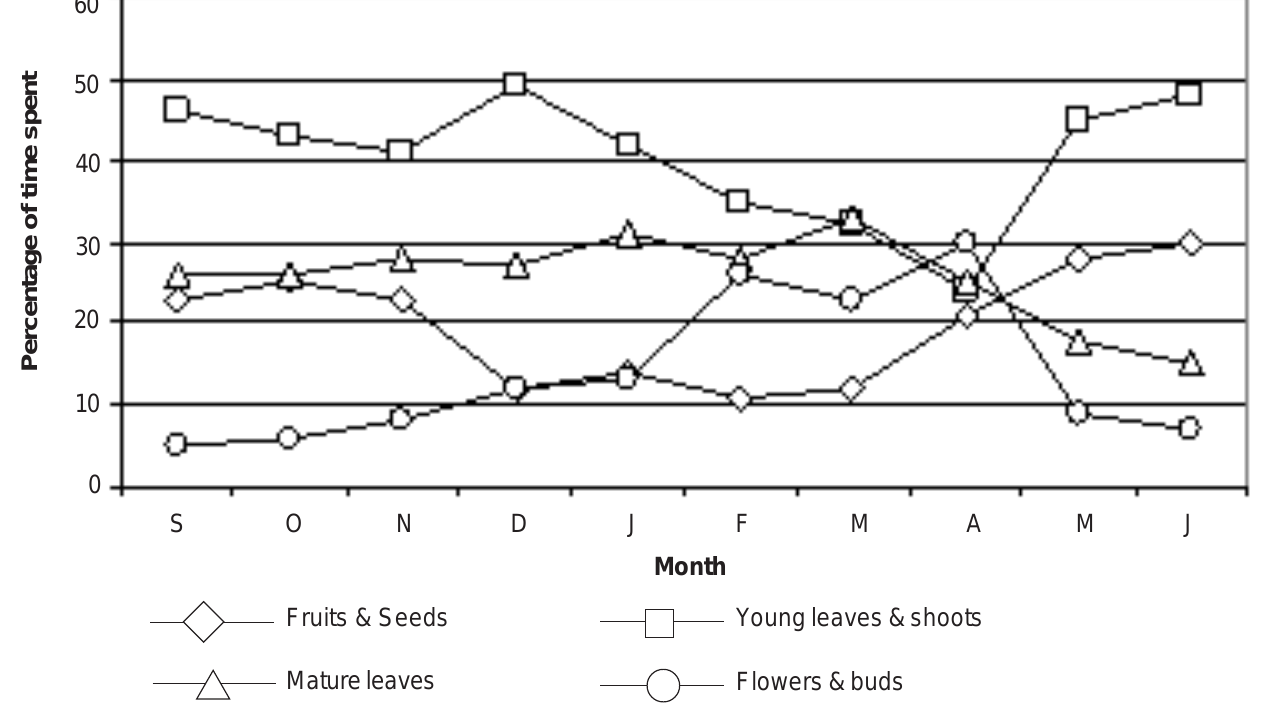
Figure 2. Monthly variation of feeding of Trachypithecus phayrei